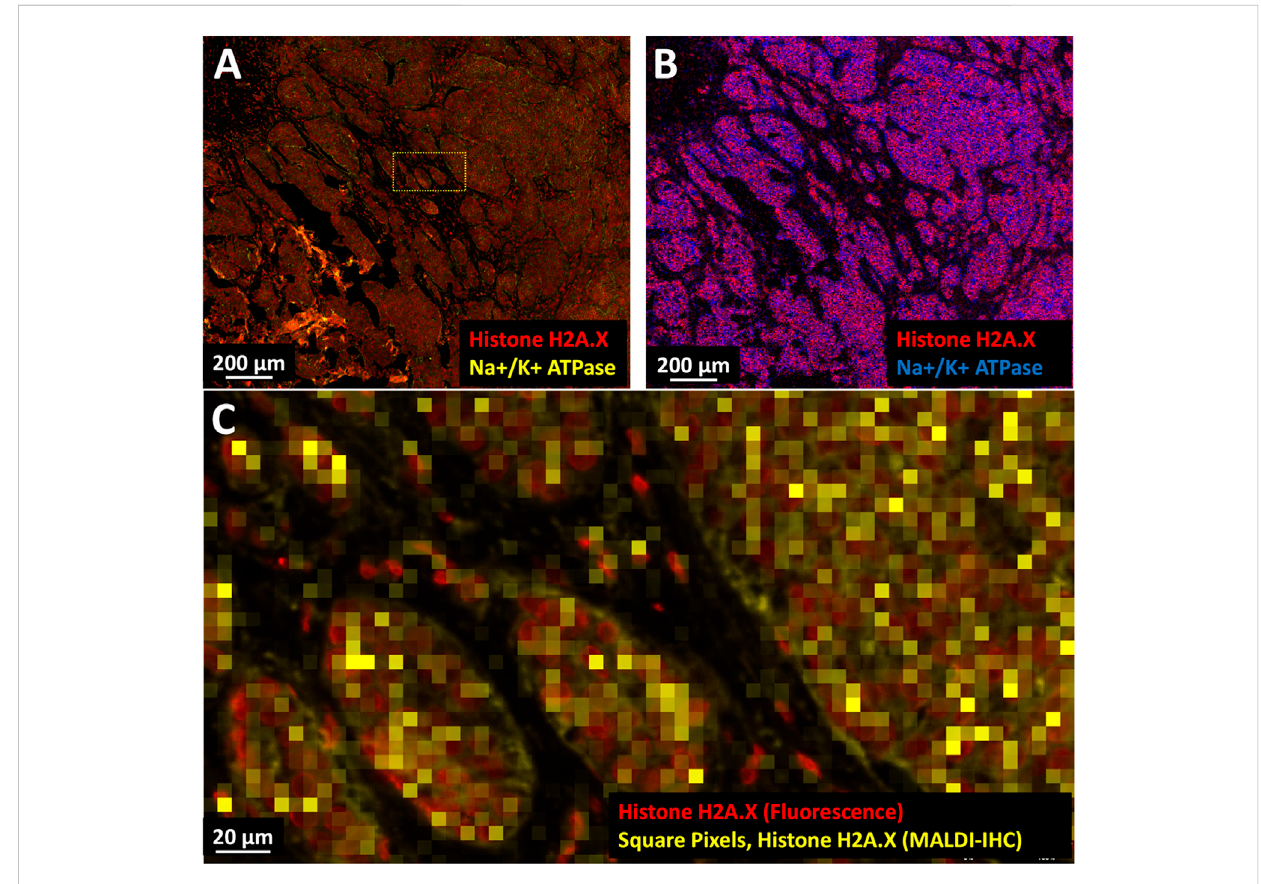
FIGURE 5 Multimodal high-resolution MALDI-IHC imaging of FFPE breast cancer tissue. (A) Two-color immuno fl uorescence microscopy image using dual- labeled Miralys ™ probes (Na + /K + ATPase and histone H2A.X, yellow and red, respectively). (B) MALDI-IHC image at 5 µm pixel size using Bruker timsTOF fl eX equipped with the microGRID accessory to image the mass-tags from the same dual-labeled probes (Na + /K + ATPase and histone H2A.X, blue and red, respectively). (C) Merge of the fl uorescent and MALDI-IHC images shown in (A) and (B) for a selected region (see cross-hatched yellow rectanglein(A).TheMALDI-IHCimagecomprisedof5×5 µmpixelsforhistoneH2A.X(inthiscasethesquareyellowpixels)wasinteractivelyalignedwith the fl uorescent image comprised of individual cell nuclei colorized as red, also histone